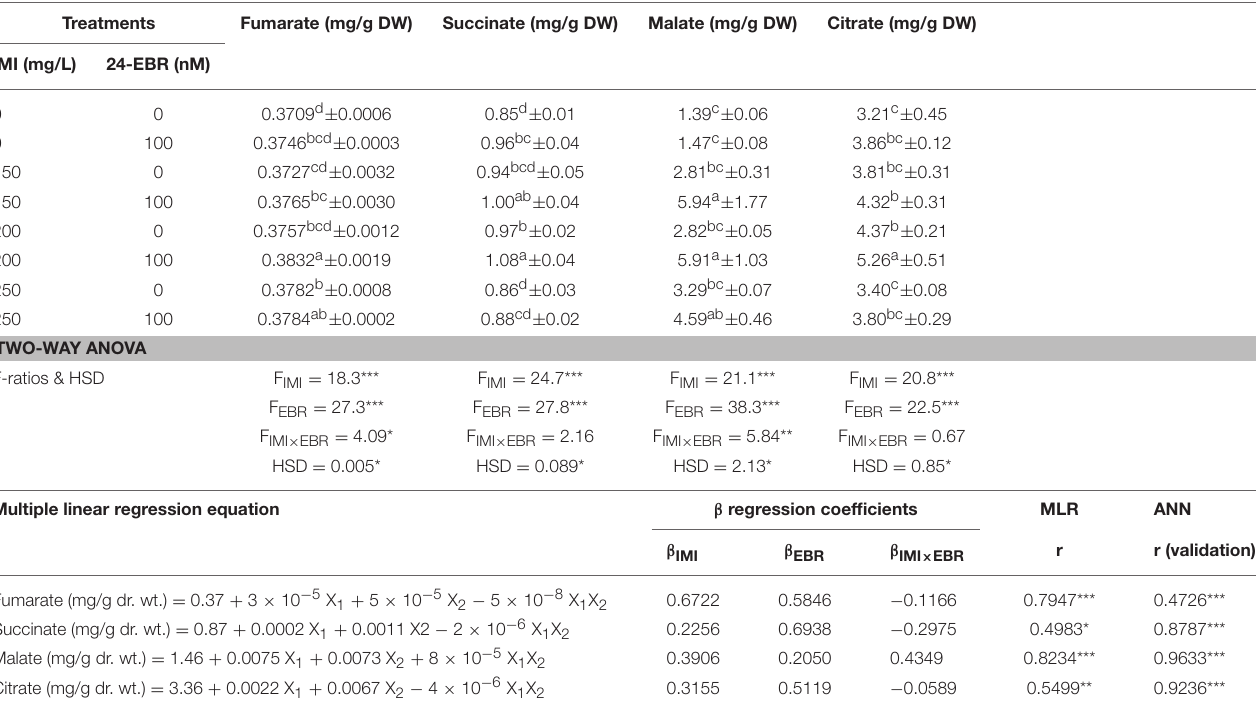
TABLE 5 | Effect of seed soaking with 24-epibrassinolide (EBR) on contents of organic acids in Brassica juncea seedlings grown under imidacloprid (IMI) toxicity.